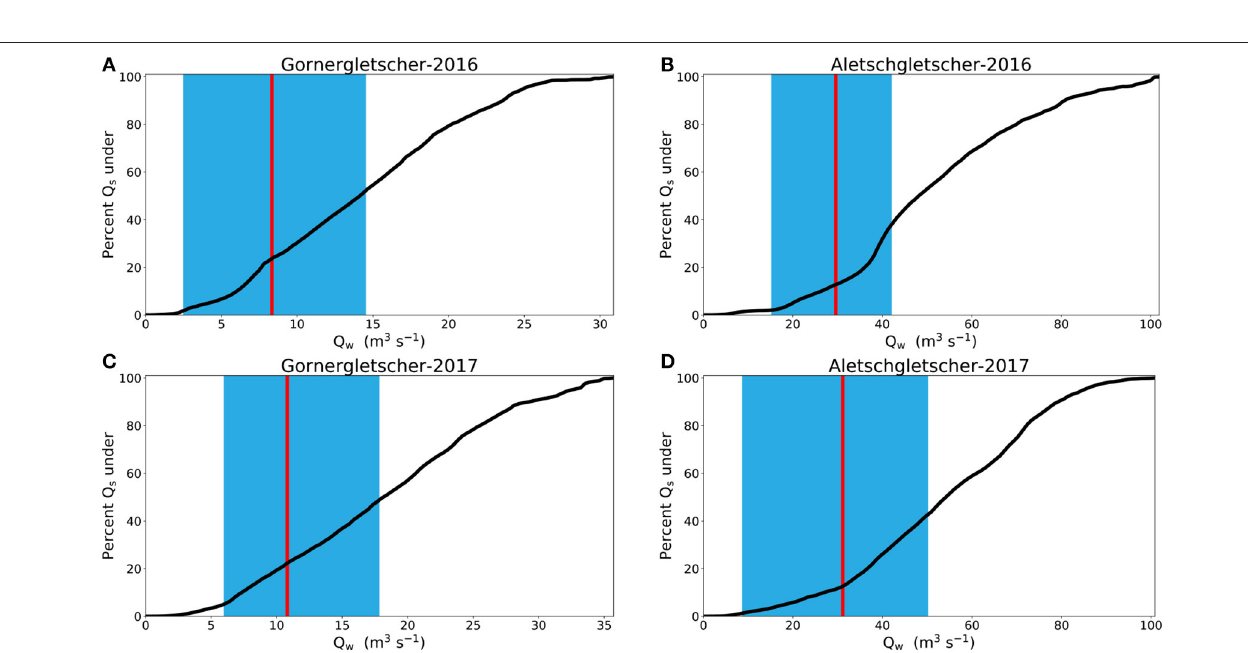
FIGURE 10 | Percentage of sediment transport (Q s ) occurring under a given water discharge (Q w ) for both catchments in 2016 (A,B) and 2017 (C,D) . The blue regions represent 25th and 75th quantiles of Q w , while red lines represent median values. Note that at the Aletschgletscher catchment, minimum water discharge values at the beginning of the 2017 season are not present due to instrument malfunctioning, and that this also leads to exaggerated mean values of water discharge when compared to 2016.